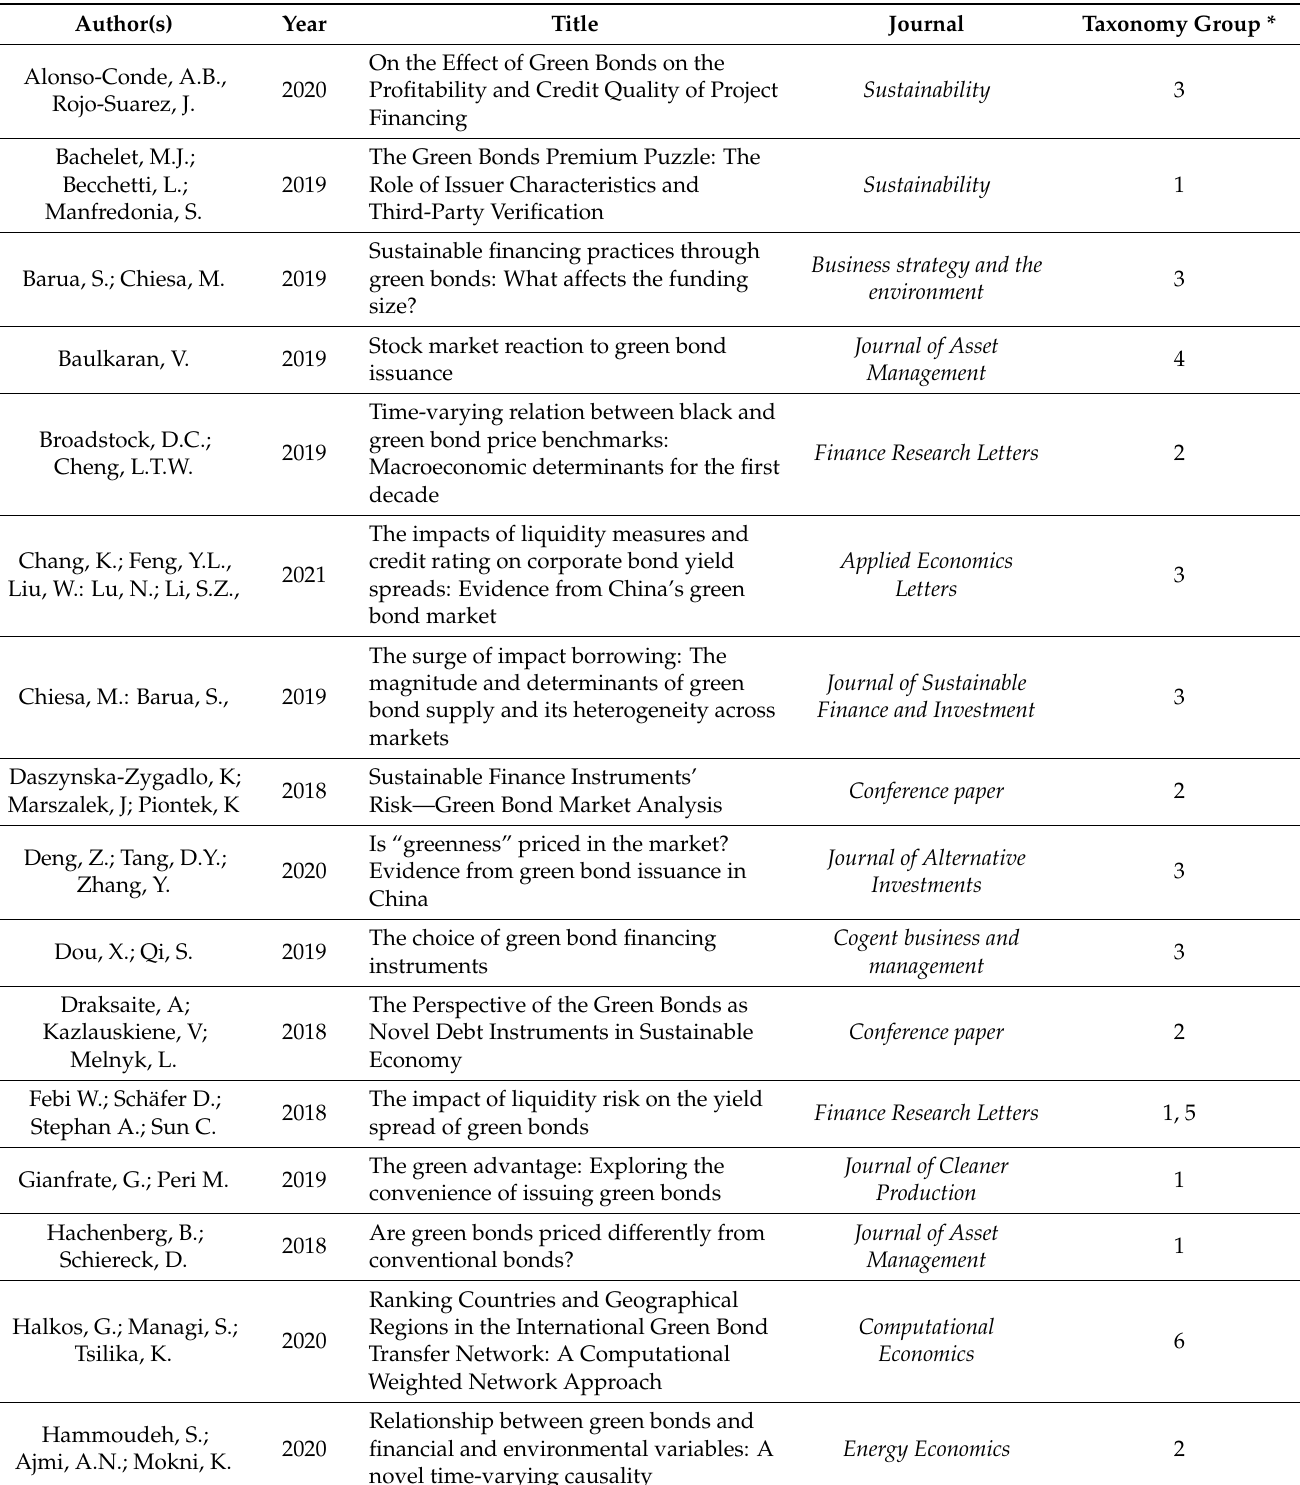
Table A1. Full list of the 53 papers included in the systematic